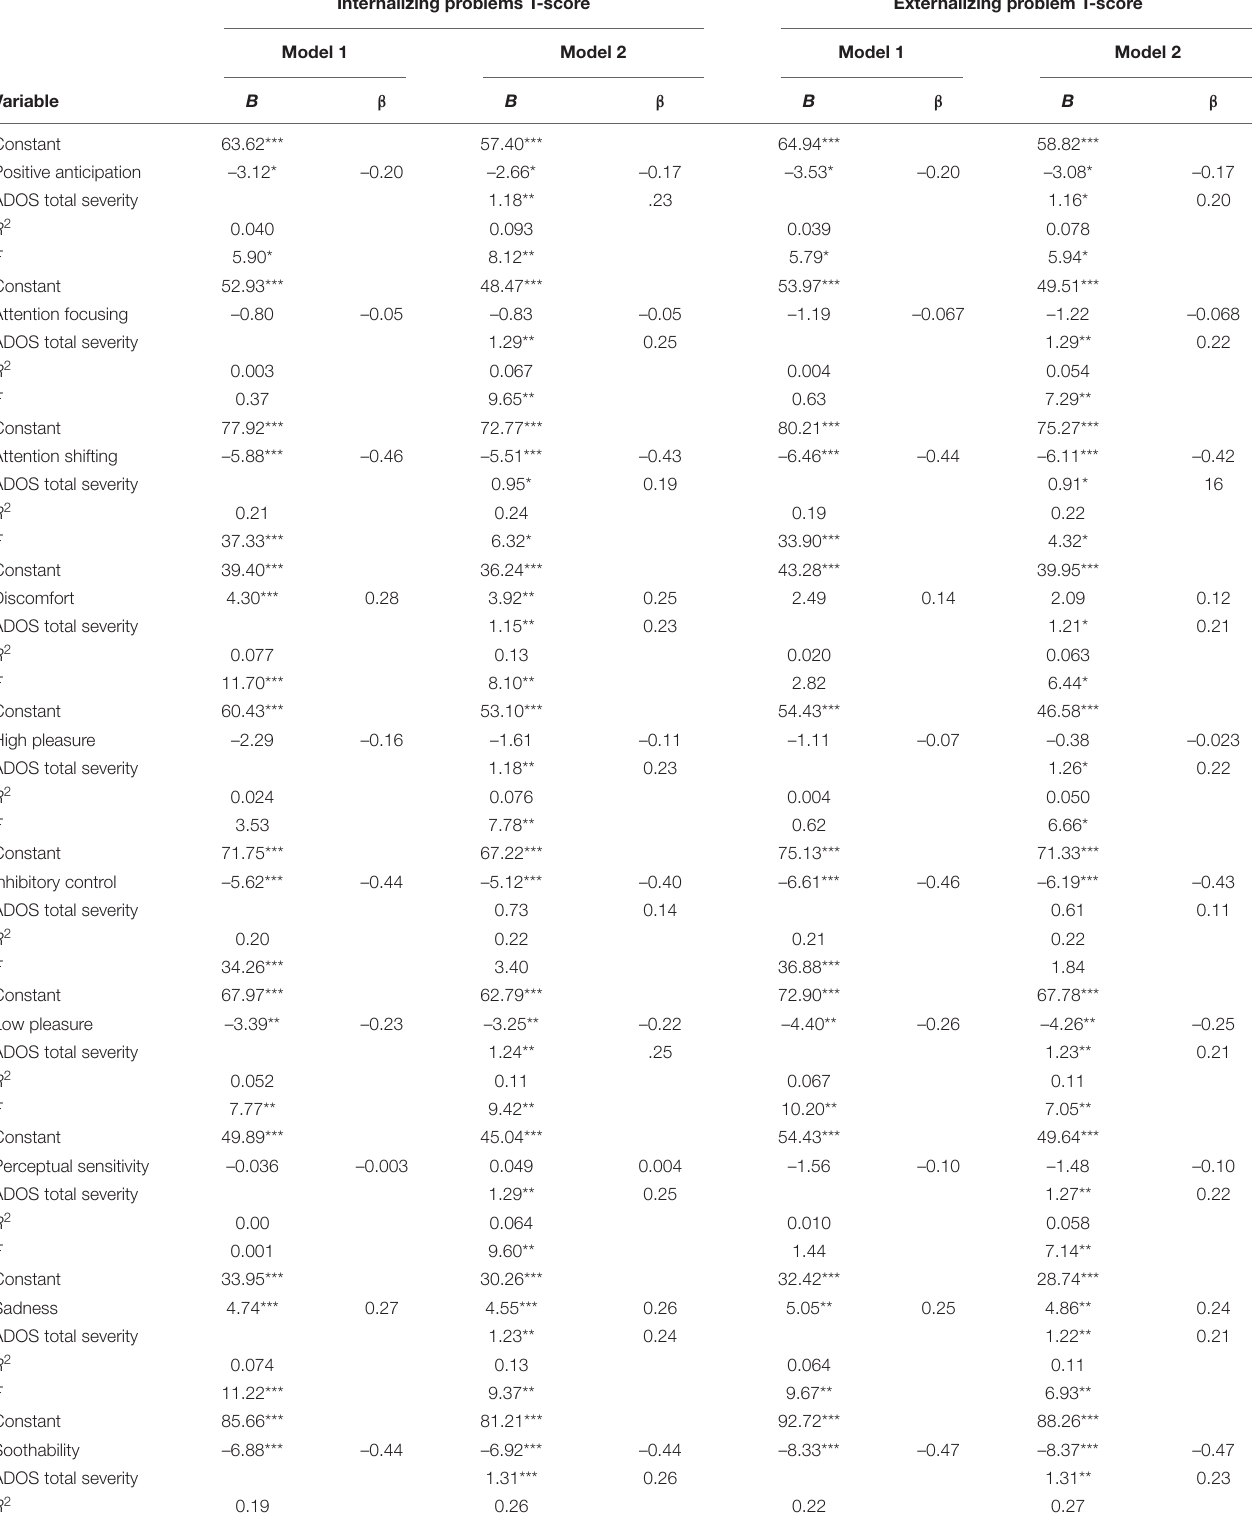
TABLE 5 | Predictive relationships between 5-year internalizing and externalizing problems and 2-year temperament